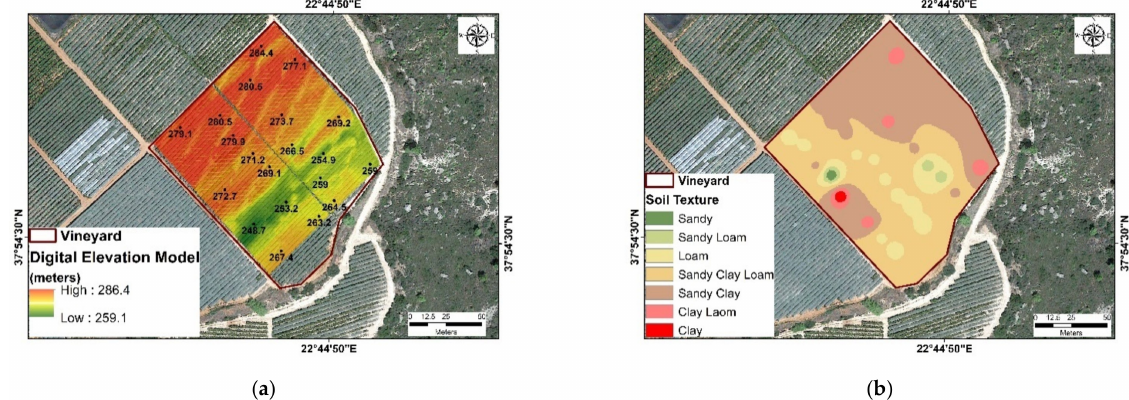
Figure 2. ( a ) Very high-resolution Digital Elevation Model and ( b ) soil texture distribution characteristics of the experimental vineyard